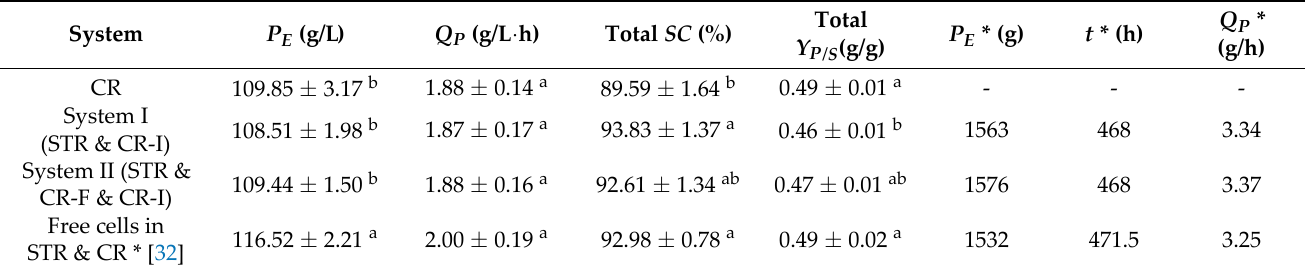
P E = ethanol concentration, Q P = ethanol productivity, SC = sugar consumption (%), Y P / S = ethanol yield (g/g), and t = fermentation time (h). a , b , c , ab Means having the same letter within the same column are not significantly different when using Duncan’s multiple range test at a p -level < 0.05. The results are expressed as the mean ± SD of triplicate experiments.